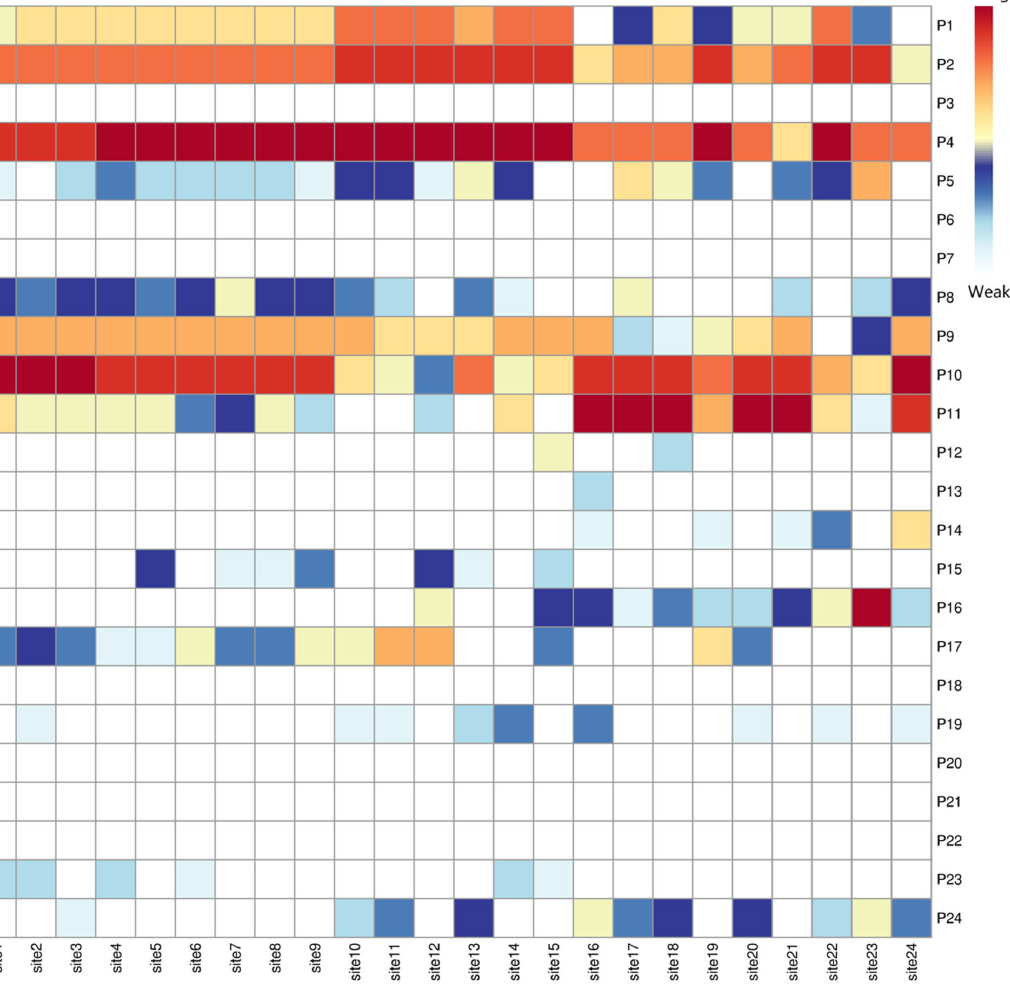
Figure 2. The sensitivity of each parameter for the simulated soil carbon using the CNOP-P method (From research findings by Sun and Mu [47]. Parameter corresponding to the number can be found in studies by Sun and Mu [47] and Table S1 in Supplementary Materials).